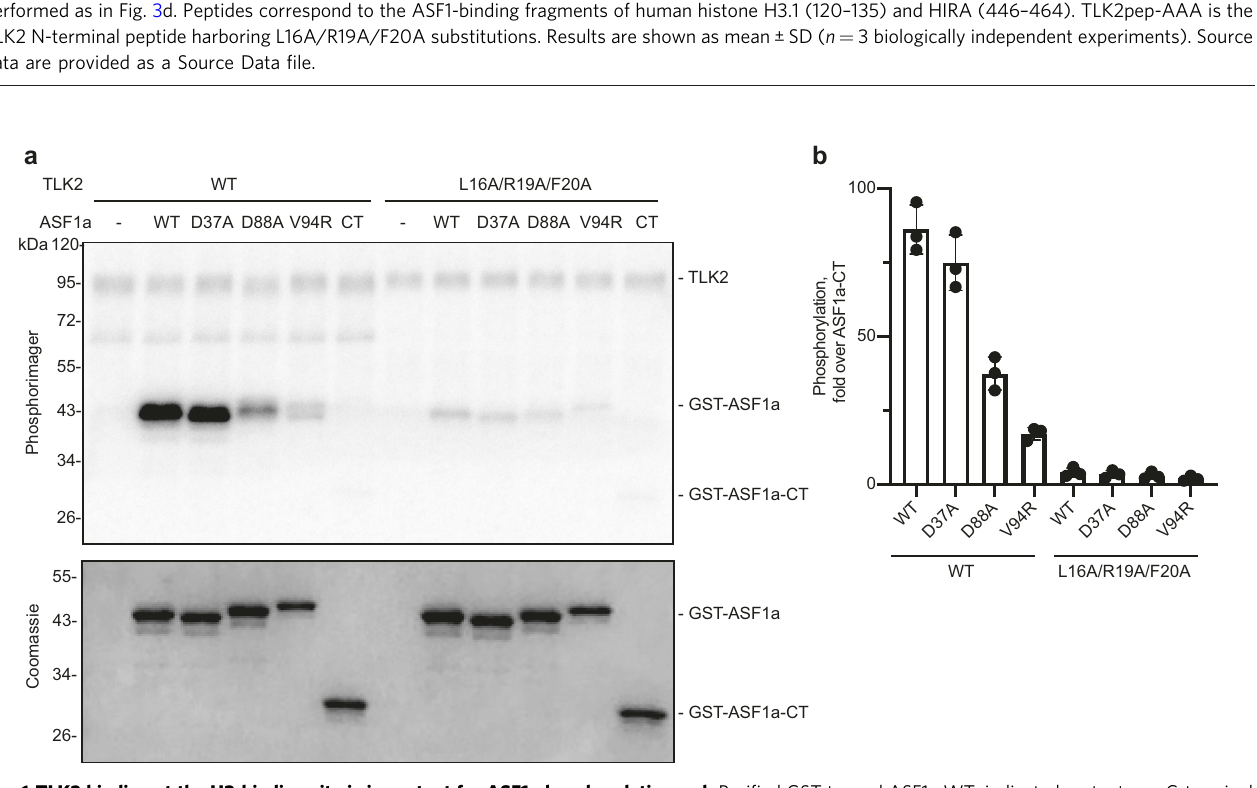
Fig. 6 TLK2 binding at the H3-binding site is important for ASF1 phosphorylation. a , b Puri fi ed GST tagged ASF1a WT, indicated mutants, or C-terminal tail residues 155 – 204 (CT) were phosphorylated by WT TLK2 or the indicated mutants with [ γ - 32 P]ATP. Samples were subjected to SDS-PAGE followed is shown relative to the level of phosphorylation of ASF1a-CT by the indicated form of TLK2. Source data are provided as a Source Data fi